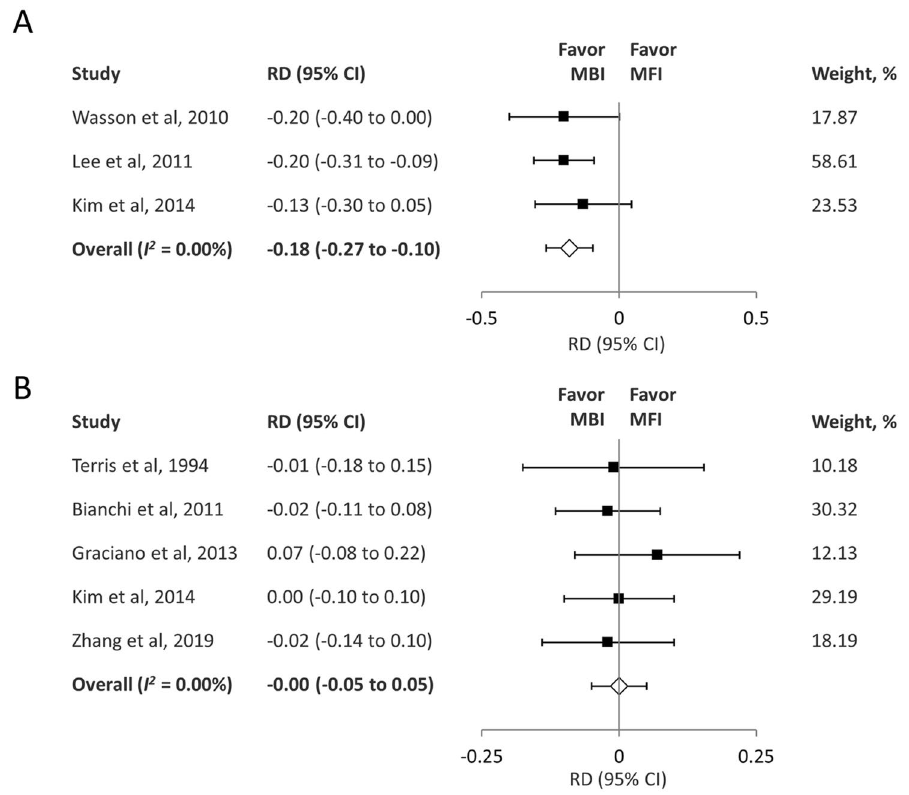
Figure 5. ( A ) Forest plot of the incidence of Frey’s syndrome after parotidectomy. ( B ) Forest plot of the incidence of salivary complications after parotidectomy. RD risk difference, CI confidence interval, MBI Blair incision, MFI modified facelift